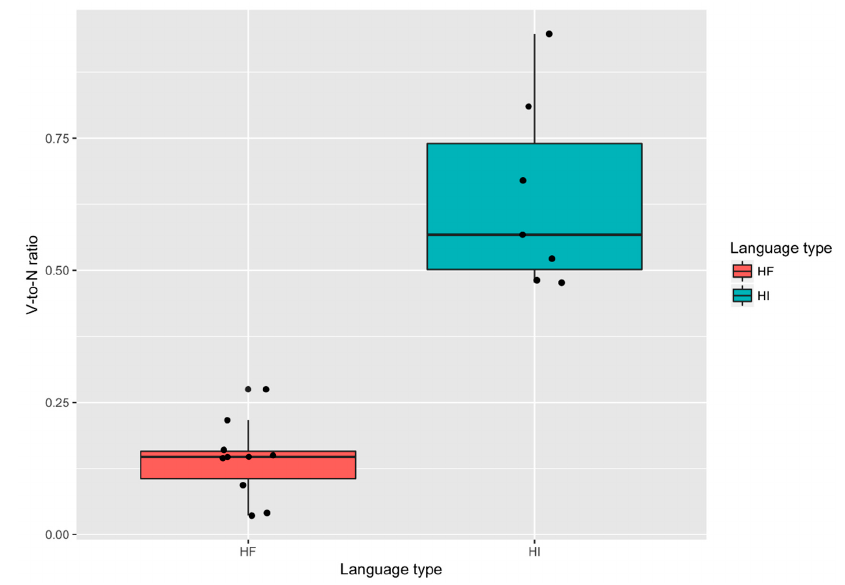
Figure 1. Verb-to-noun ratios, head-final (HF) and head-initial (HI) languages.